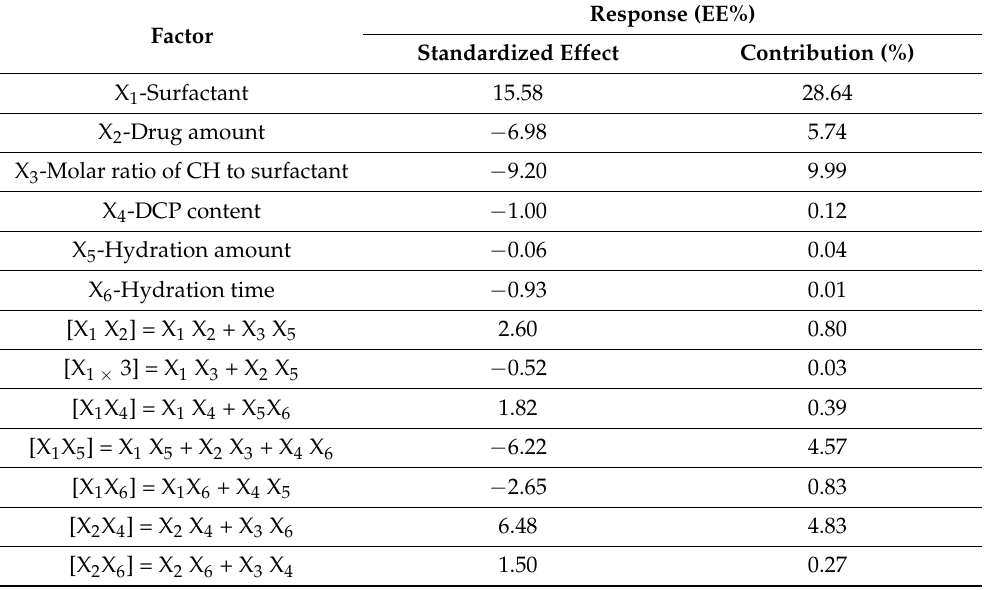
Table 4. Main effects of single factors and two-factor interactions in EGCG-niosome variable screening.